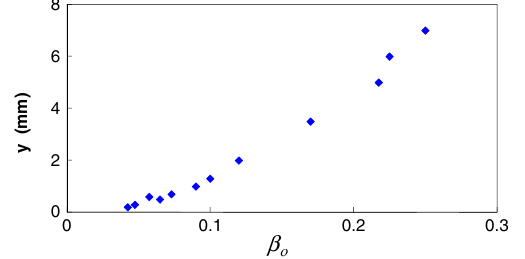
FIG. 8. Optimum beam offset y vs (cid:1) below 0 : 1 mrad = ½ð MV = m Þð q=A Þ(cid:8) in the set of 12 QWRs of Fig. 6, calculated with formula (15). At higher (cid:1) offset approaches the beam port aperture radius.